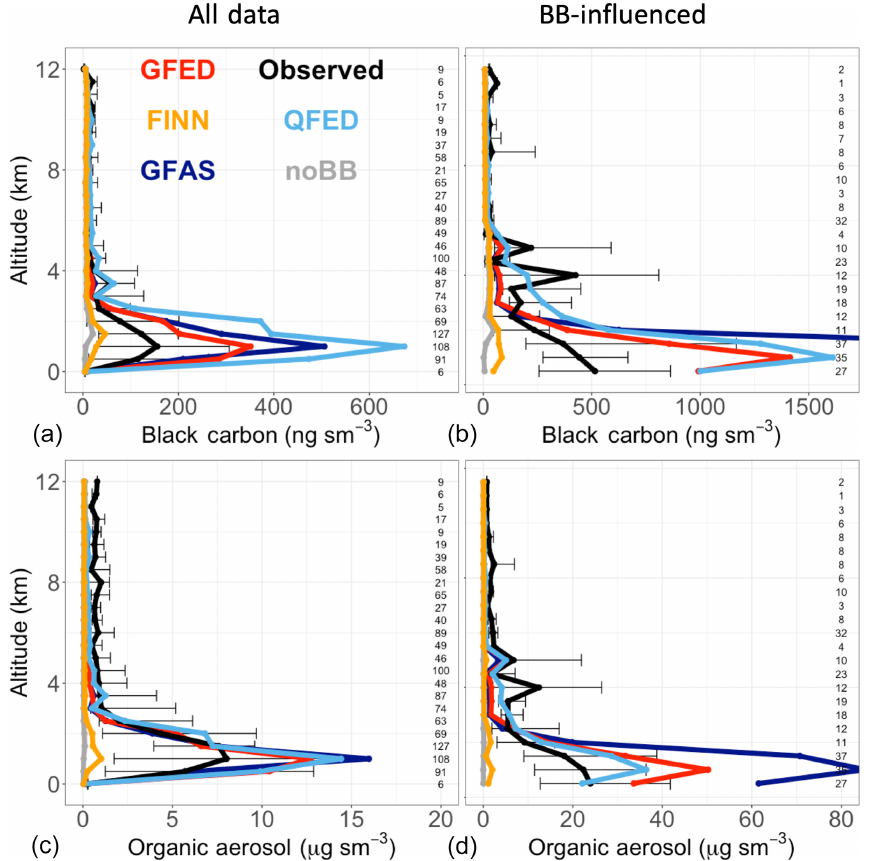
Figure 10. The median vertical profiles of BC and OA mass concentrations (shown in 0.5km bins) from the boreal part of the ARCTAS campaign. Observations (black) are compared with simulations using the four fire inventories – GFED4s (red), FINN1.5 (orange), QFED2.4 (light blue), and GFAS1.2 (dark blue) – and a simulation with no fire emissions (noBB) in gray. Error bars show the 25th–75th percentile range of measurements averaged in each vertical bin. The number of observations in each bin is given on the right side of each panel. Panels (a, c) show total results for the campaign. Panels (b, d) show results filtered for the top 25th percentile of observed acetonitrile. Note the different scale among